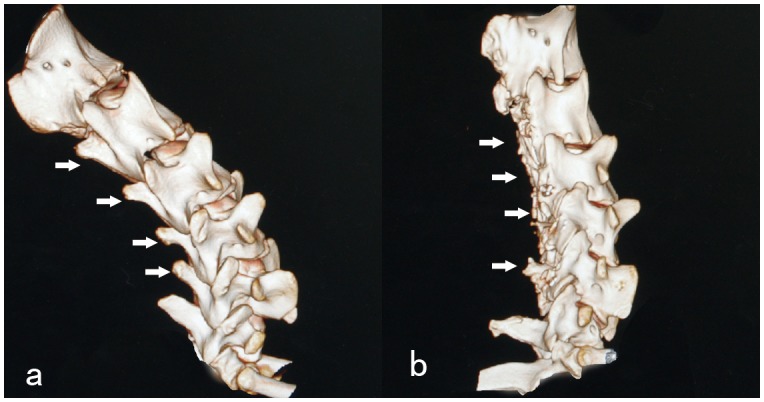
CT reconstruction of the cervical spine.a show the preoperative picture of the spinous process (C3–C6, arrows); b show the picture of the spinous process six months after surgery, the spinous process of the surgical vertebra is almost gone (C3–C6, arrows).